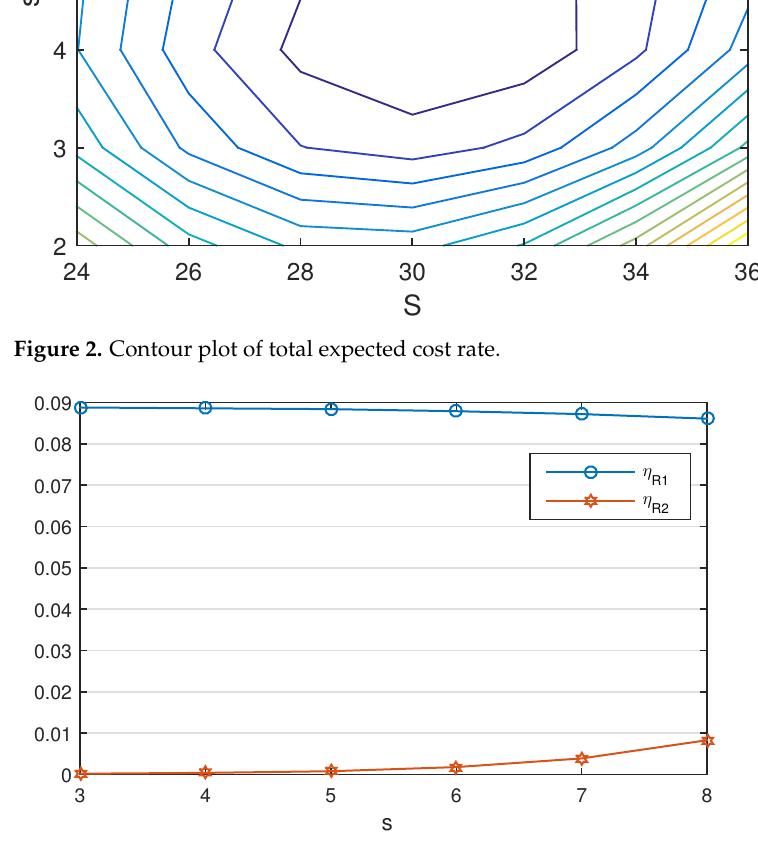
Figure 3. Mean reorder rate for two suppliers vs. s .